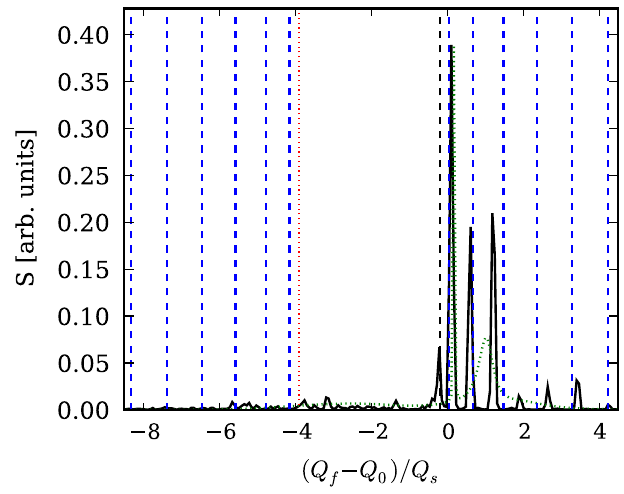
FIG. 6. (Color) Simulation noise spectrum from a parabolic bunch for (cid:1) Q sc =Q s ¼ 1 : 5 together with Q k from Eq. (8). The dashed blue and black ( k ¼ 0 ) lines indicate the analytic results from Eq. (8). The dotted red line represents the maximum incoherent space charge tune shift (cid:1) Q sc in the bunch. The dotted green curve represents the Schottky spectrum for the equivalent coasting the power spectrum for the corresponding coasting beam (dotted green curve in Fig. 6) with a space charge parame- ter U sc ¼ (cid:1) Q max =(cid:2) eff (see Ref. [3]). We also observe addi- tional satellites, like the one at ð Q f (cid:1) Q 0 Þ =Q s (cid:2) (cid:1) 1 in Fig. 6. These additional lines disappear for stronger space charge. In Fig. 7 one can observe that for stronger space